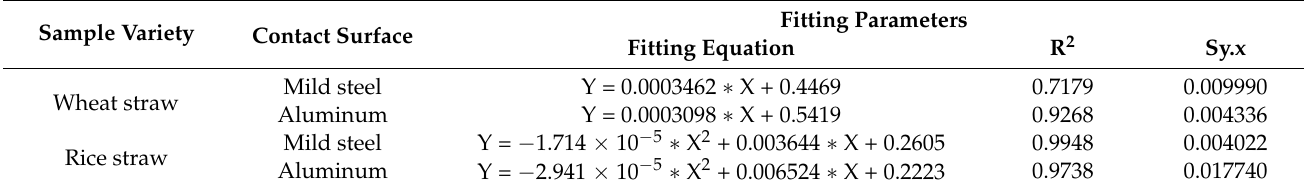
Table 8. The fitting model of the coefficient of sliding friction based on